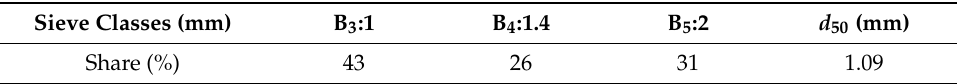
Table 2. Standardized particle size distribution of the samples.